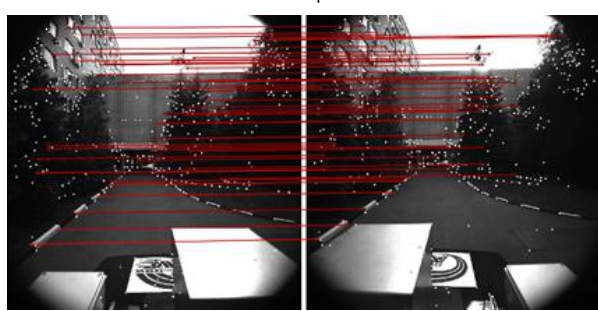
Figure 1 . The result of the algorithm for interest points detection and descriptors extraction.